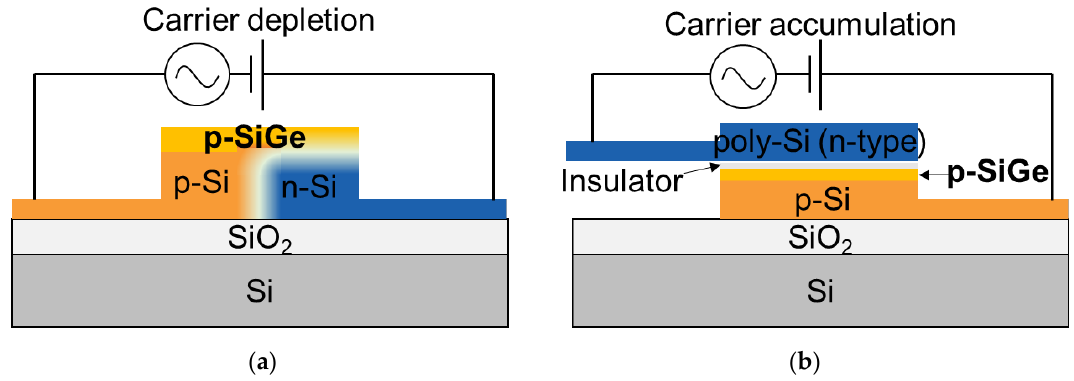
Figure 3. ( a ) Schematic cross-sections of ( a ) carrier depletion type [57] and ( b ) accumulation type [58] modulators using a strained p-SiGe layer to enhance plasma dispersion effect.